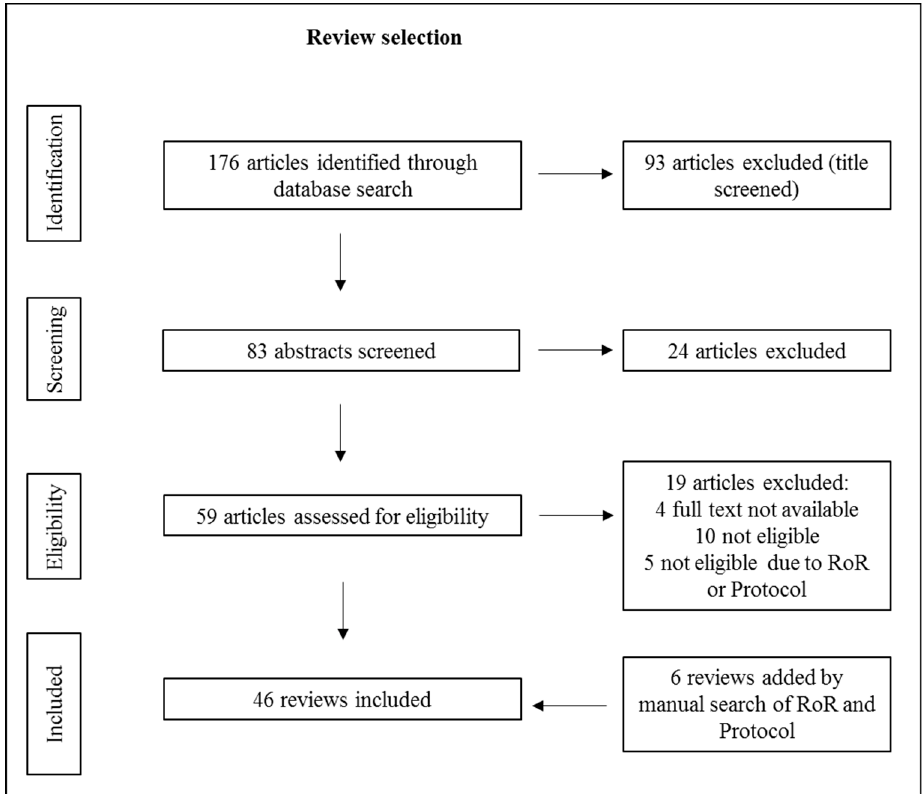
Figure 1. Flow chart of the review selection process (step 1). Since not all included reviews provided suitable primary studies, we provide a Supplementary appendix with all reviews from which we included primary studies.